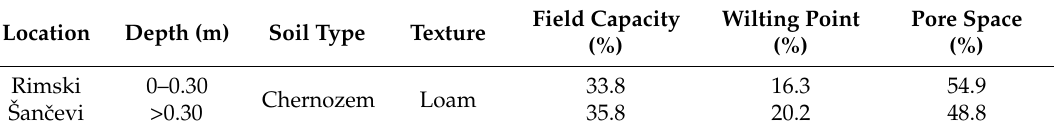
Table 1. The hydrological characteristics of the soil used in the